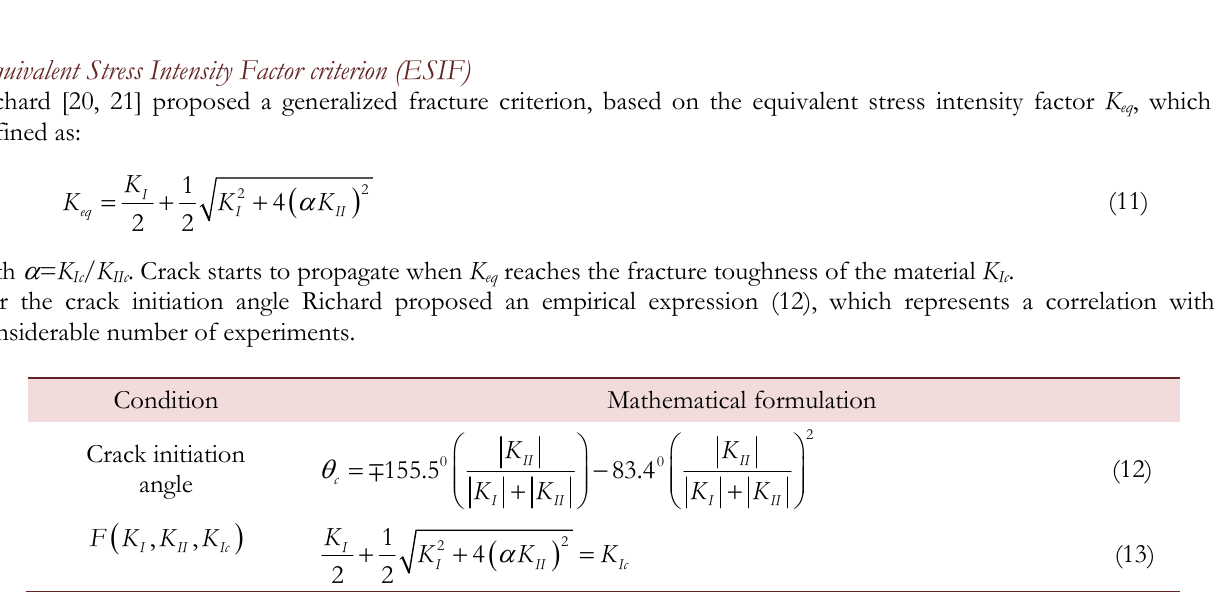
Table 4: The ESIF criterion.